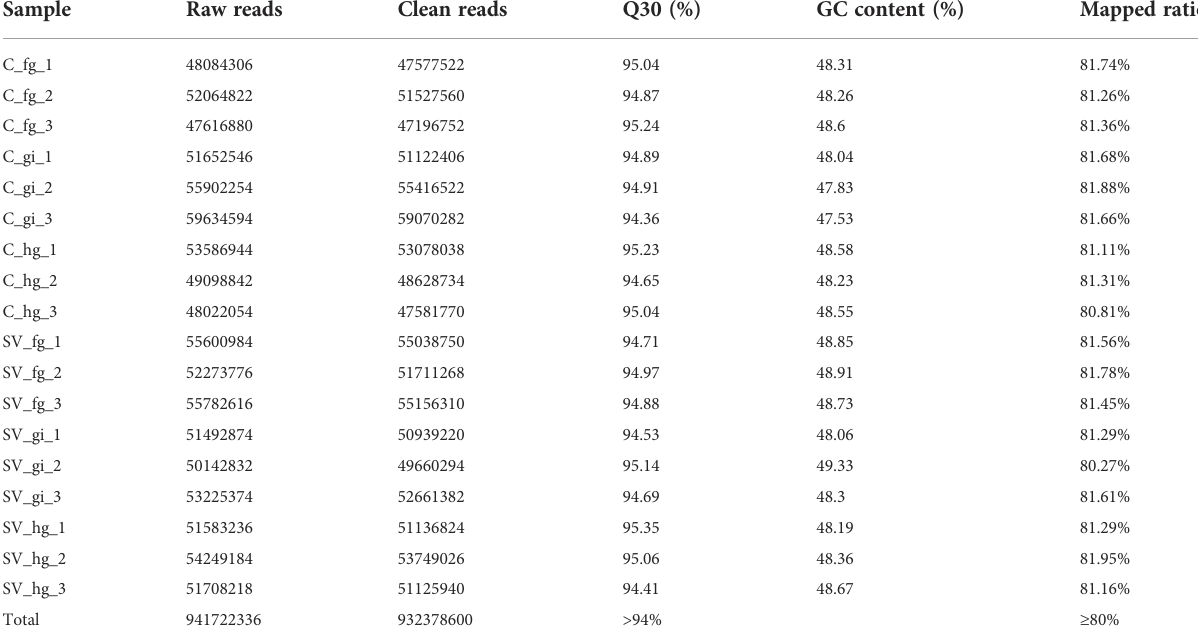
TABLE 2 Statistical table of sequencing